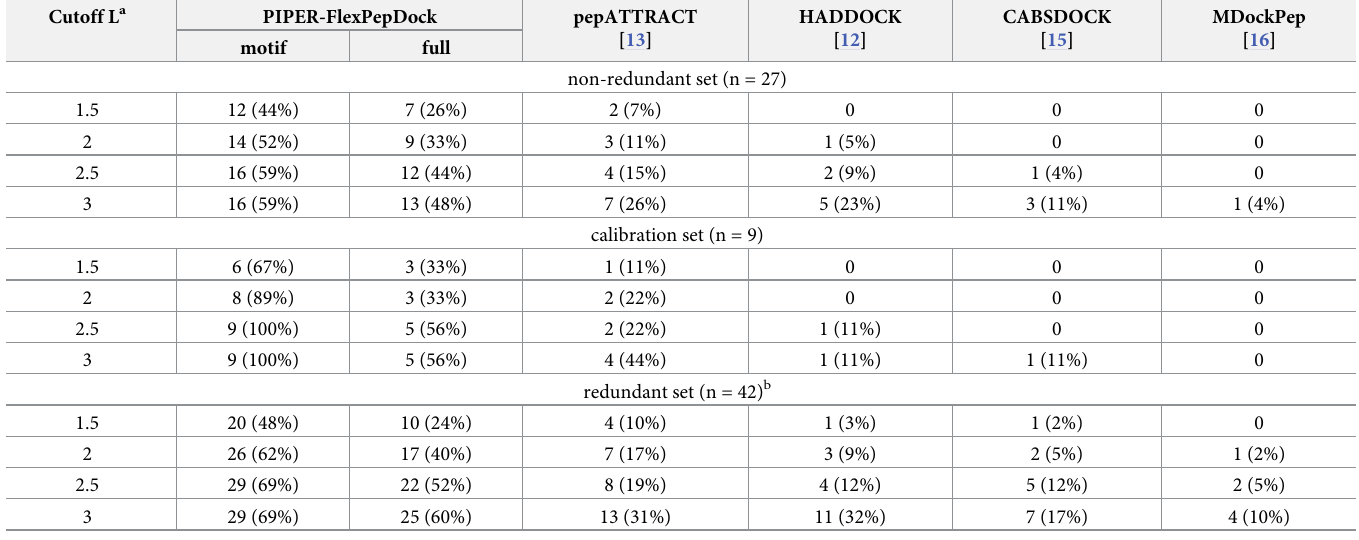
Table 2. Summary of performance of PIPER-FlexPepDock, and comparison to other peptide docking protocols. Results are shown for PIPER-FlexPepDock runs on unbound receptor structures, including receptor minimization. Cutoff L